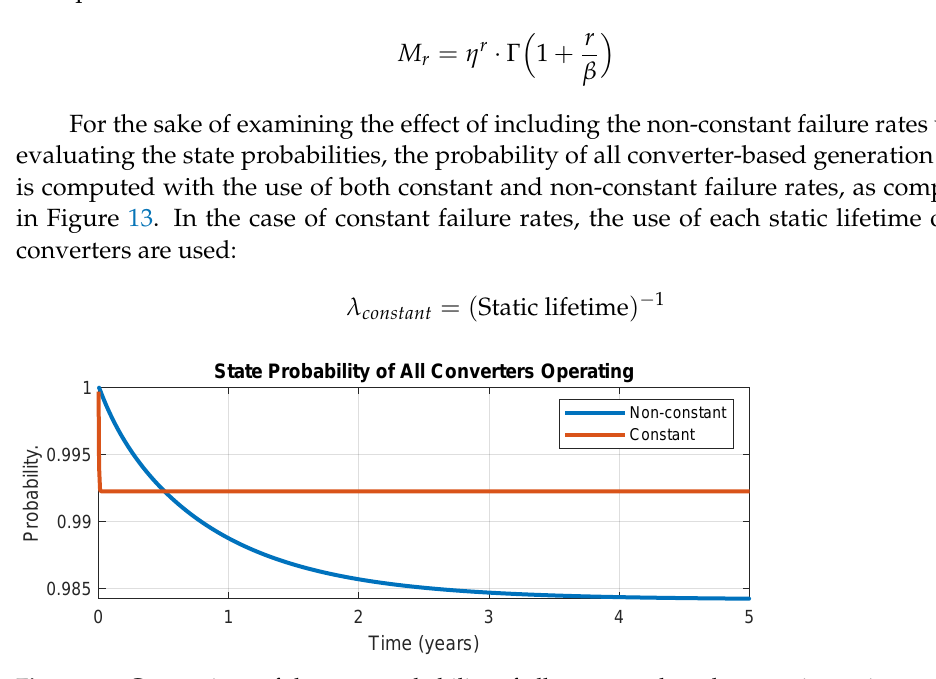
Figure 13. Comparison of the state probability of all converter-based generation units operating when using constant and non-constant failure